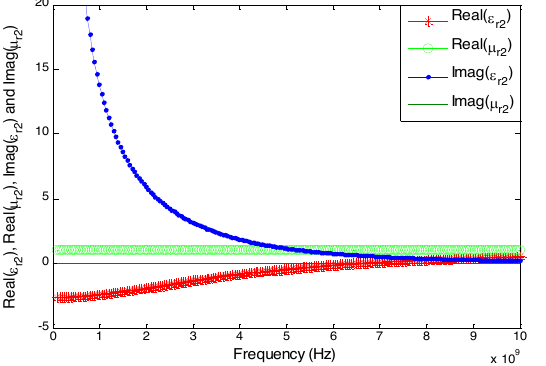
FIGURE 3. Real and imaginary parts of relative permittivity, ε r2 , and permeability, µ r2 , of Rods only media versus frequency for γ e = 4.05248 GHz, f ep = 7.71387 GHz.